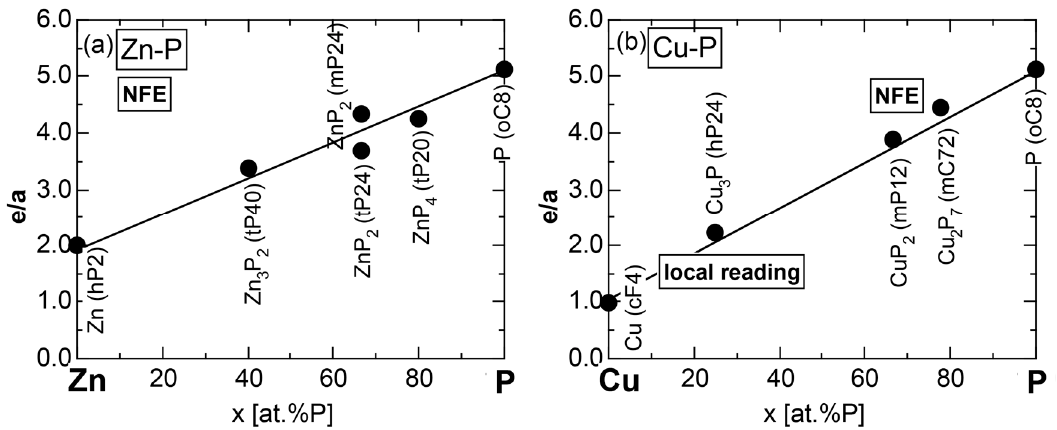
Figure 76. Composition dependence of e/a for intermetallic compounds and pure elements in ( a ) Zn-P and ( b ) Cu-P alloy systems [11]. The linear interpolation rule holds well in (a) and (b).